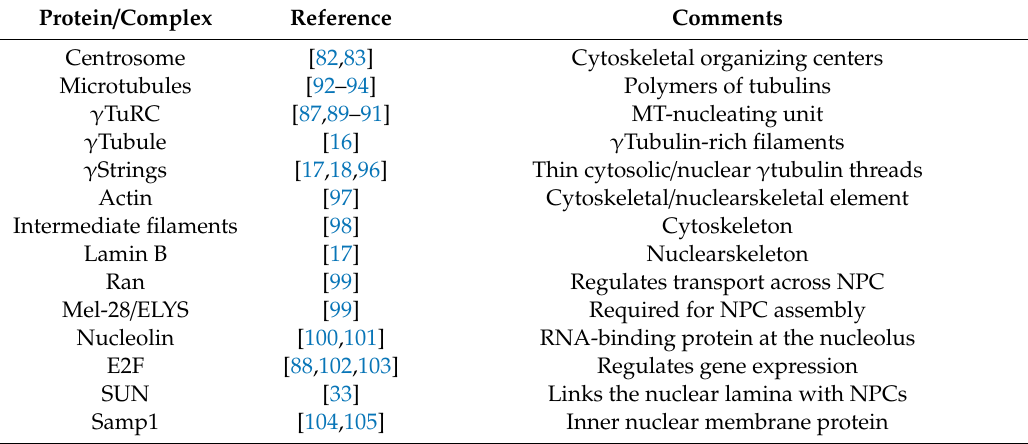
Table 1. Proteins and protein complexes that both interact with γ tubulin and a ff ect nuclear